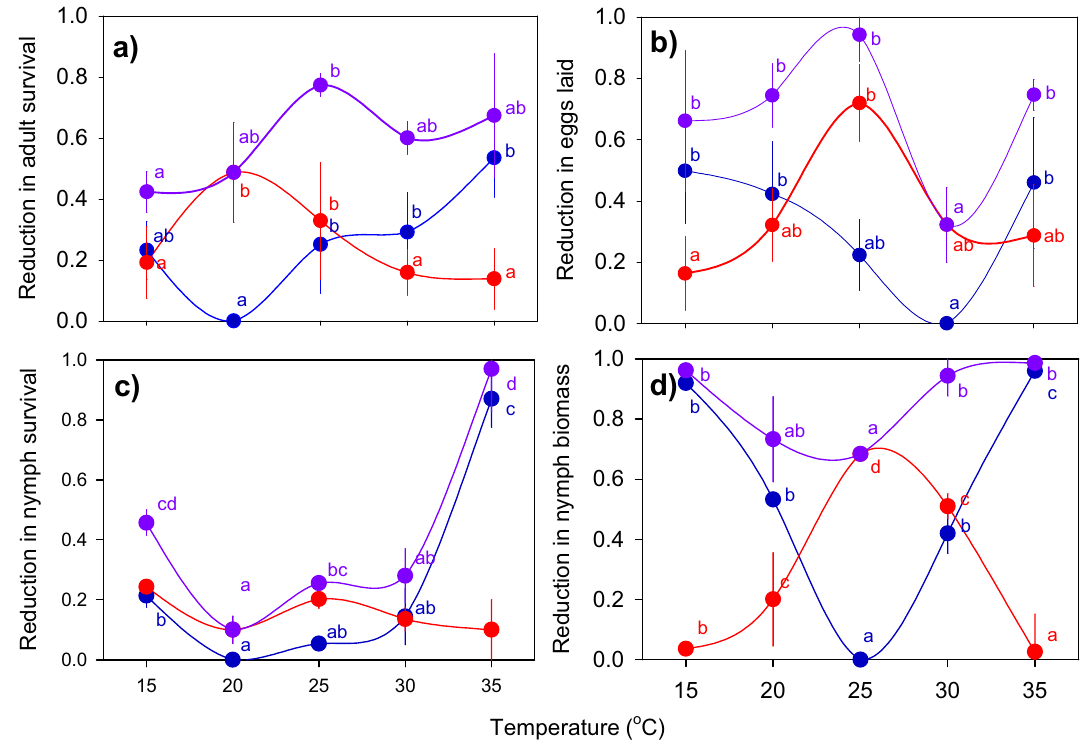
Figure 6. Reductions in the fitness of Nilaparvata lugens on IR62 over a temperature gradient. Graphs indicate the total reductions (violet circles) in adult longevity ( a ), the number of eggs laid ( b ), nymph survival ( c ) and nymph biomass ( d ). In each case, this is composed of a fitness reductions due to temperature (blue circles – estimated based on reductions relative to optimal temperatures on a highly susceptible variety) and reductions due to the resistance gene(s) (red circles – estimated as the total reduction minus the temperature-related reduction in fitness). Standard errors are shown (N = 4 for a and b , N = 5 for c and d ). Lowercase letters indicate homogenous temperature groups (Tukey, P < 0.05).